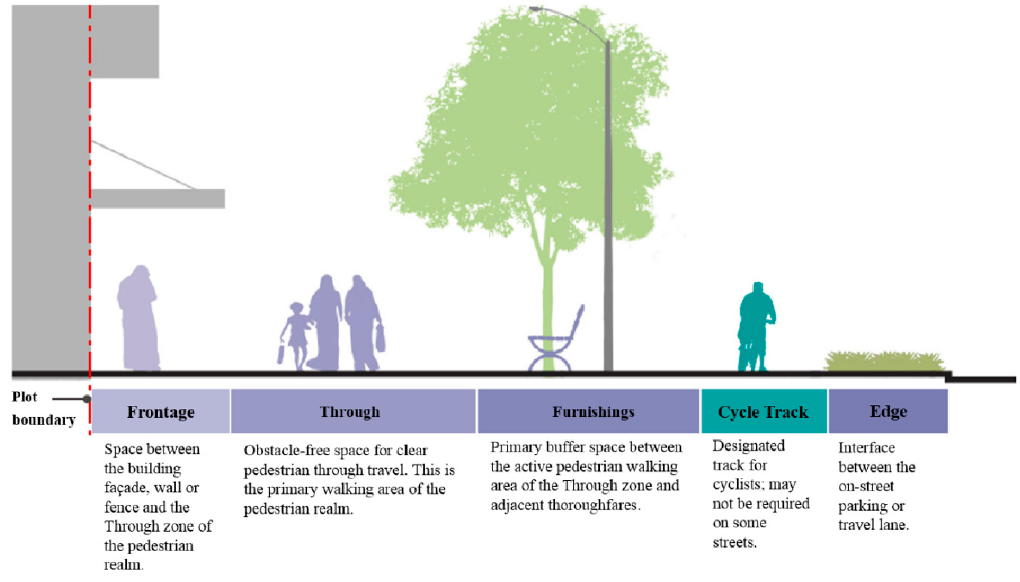
Figure 4. An example of a cross section for a street showing public realm zones and shading elements (Source: [53]).